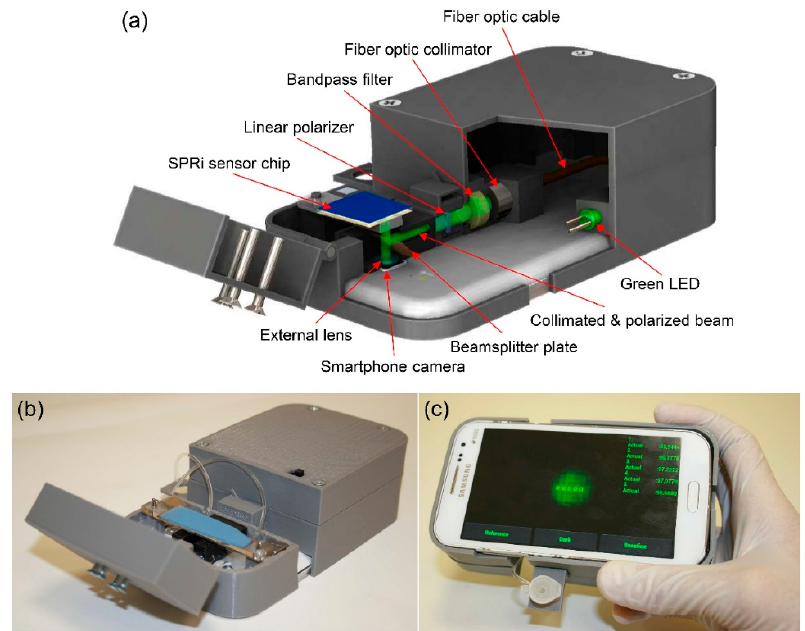
Figure 3. Surface plasmon resonance imaging platform integrated with a smartphone. ( a ) Schematic illustration and ( b ) photograph of the imaging apparatus. ( c ) Custom developed smartphone application for real-time and on-site monitoring of multiple sensing spots. Reprinted permission obtained from [69] .